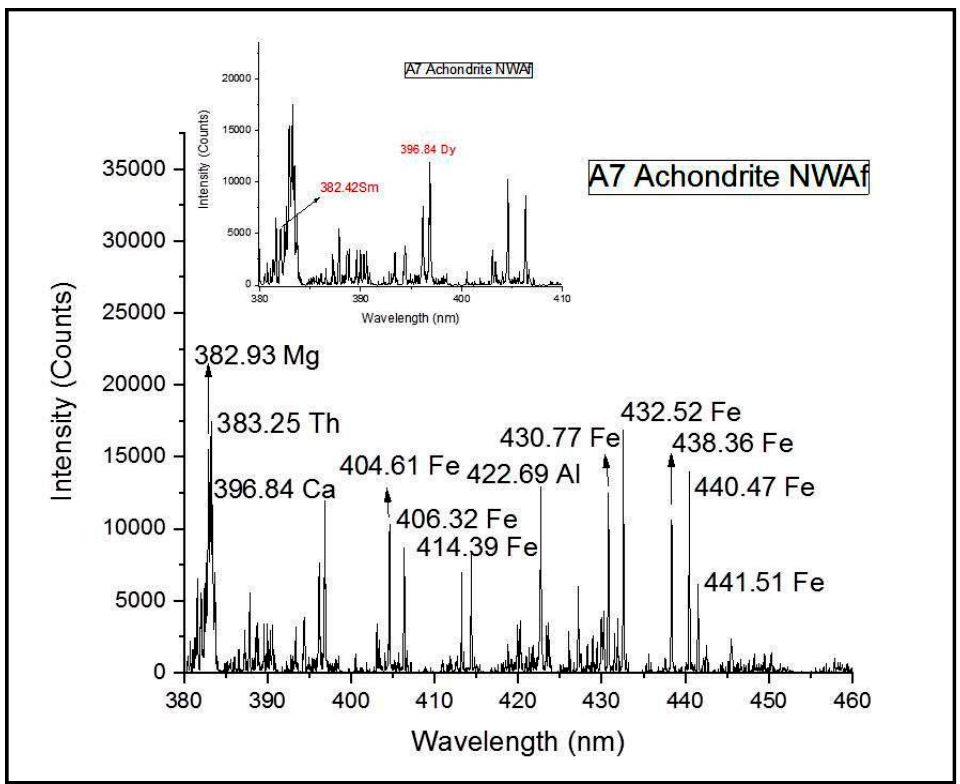
Figure 8. LIBS spectrum of sample A7 with the REEs identified at shorter wavelength range in inset. Although the initial assignments were calculated only for the most intense lines in the spectrum, which usually confirmed the presence of most of the major and minor com- ponents expected, to confirm the presence of the rare Earths, a few weaker emissions were also studied, and this gave more convincing evidence of the presence of these rare Earth elements. The presence of dysprosium was reconfirmed by the lines at 403.36 nm and 420.19 nm. Similarly, the lines at 403.07 nm, 404.02 nm, 406.72 nm, 426.02 nm and 429.47 nm show the presence of scandium in the sample. The presence of neodymium was indi- cated by the lines at 423.41 nm and 428.27 nm, while the lines at 423.65 nm and 431.90 nm reconfirmed the presence of samarium.